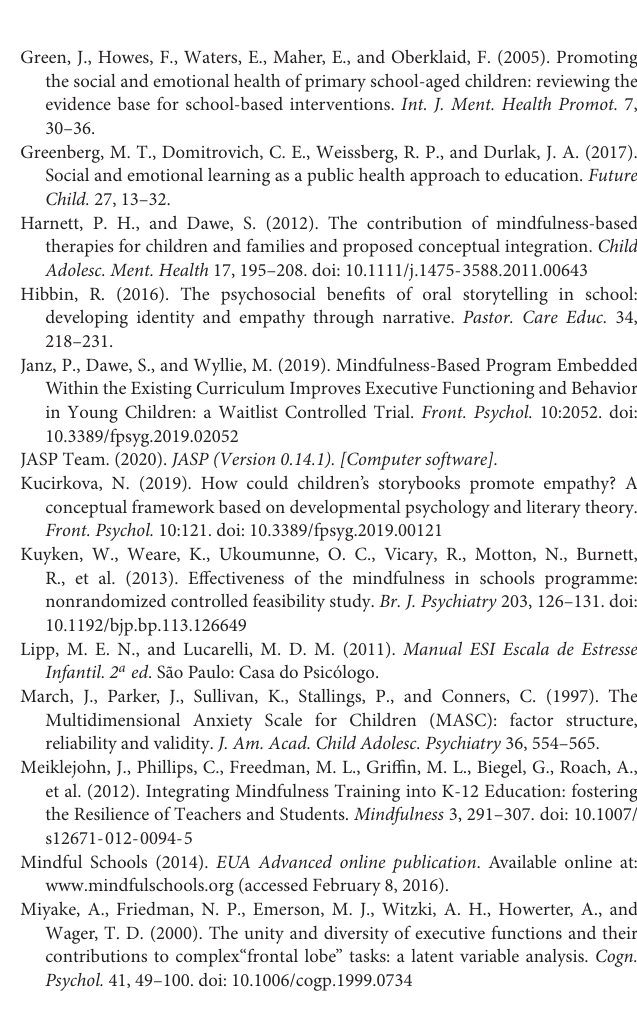
Supplementary Figure 1 | FDT [Reading (time), Counting (time), Choosing (time), Shifting (time) Inhibition, and Flexibility] scores obtained by school 1 and school 2 at baseline (T0) and after interventions (T1). Supplementary Figure 2 | FDT [Reading (errors), Counting (errors), Choosing (errors) and Shifting (errors)] scores obtained by school 1 and school 2 at baseline (T0) and after interventions (T1). Supplementary Figure 3 | Emotional health scores obtained by school 1 and school 2 at baseline (T0) and after interventions